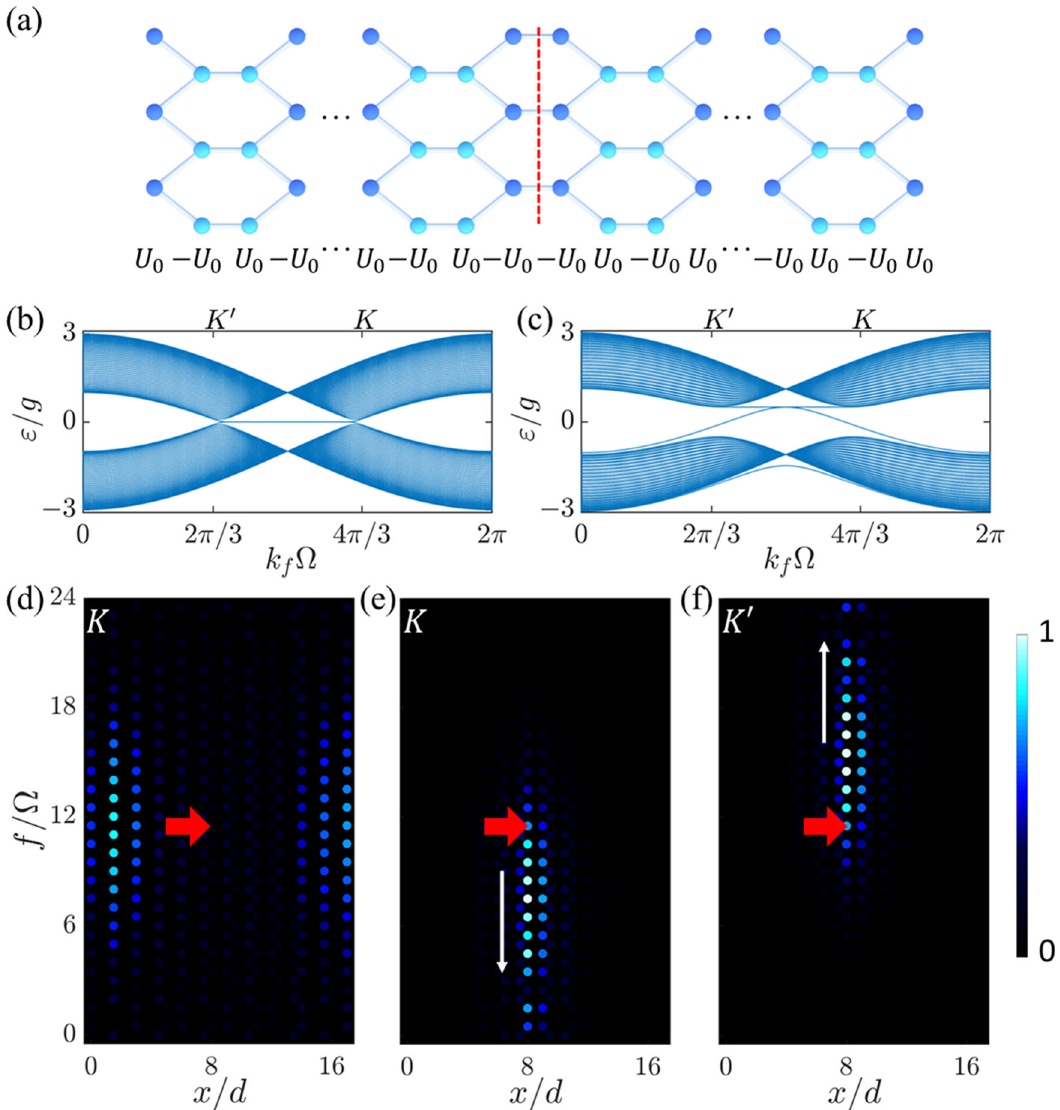
Fig. 3 Valley-dependent edge state. a Effective on-site potentials ( U 0 and − U 0 ) are alternatively applied in the synthetic lattice [formed by spatial dimension ( x ) and frequency dimension ( f )], with an arti fi cial domain wall in the middle two columns of synthetic lattices (labeled in red dashed line). The projected band structure in fi nite rings with b U 0 = 0, and c U 0 = 0.5 g . k f is the wave vector reciprocal to frequency axis, ε is the frequency shift of the fi eld, Ω is the free spectral range, and g is the effective hopping amplitude. K and K 0 are two Dirac points. The simulated intensity distributions at propagation time t = 10 g − 1 under conditions: d U 0 = 0, and k f = 4 π /3 Ω ; e U 0 = 0.5 g , and k f = 4 π /3 Ω ; f U 0 = 0.5 g , and k f = 2 π /3 Ω . d labels the horizontal distance between two sites with same types in the synthetic lattice. Red arrows indicate the excitation at the 12th ring with the central frequency mode at f 2 = 11.5 Ω . White arrows denote the unidirectional